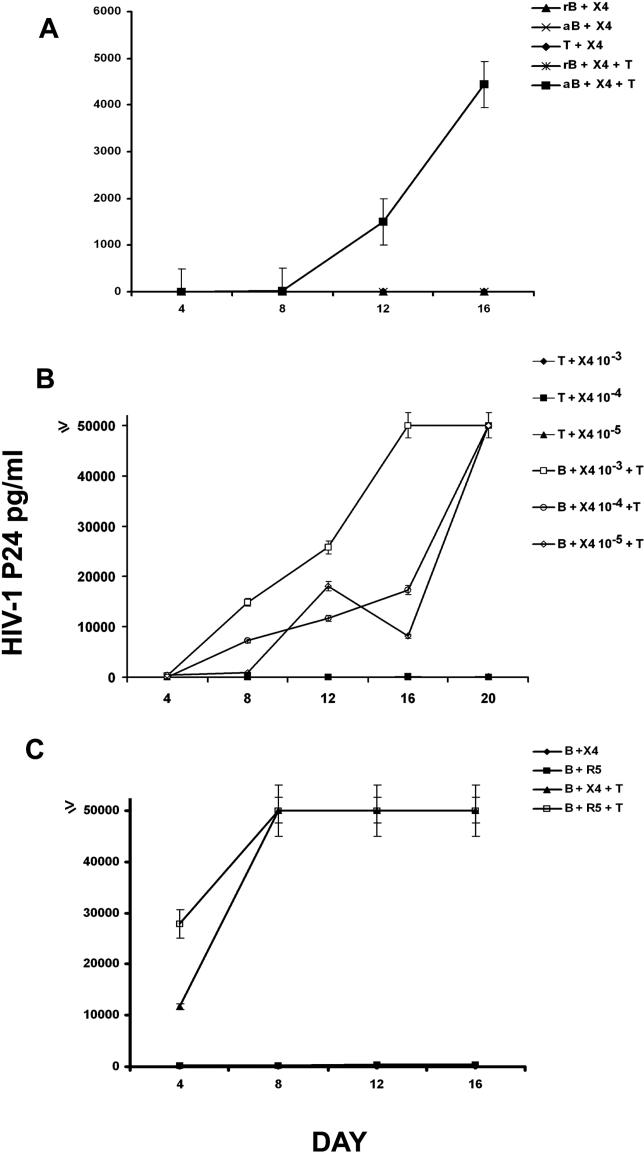
Activated B Cells Transmit HIV-1 X4 and R5 to T Cells(A) Levels of HIV-1 p24 in B cells stimulated with IL-4 and CD40L (activated B cells [aB]) or mock stimulated (resting B cells [rB]) for 24 h and loaded with 10−4 MOI of HIV-1 X4 (IIIb) for 2 h at 37 °C, then extensively washed in cold medium and incubated with purified, autologous CD4+ T cells (T). B cells and T cells directly loaded with HIV-1 served as controls.(B) Dose response of HIV-1 trans infection shown by levels of p24 in cultures of autologous T cells (T) mixed with activated B cells (B) that were loaded with 10−5, 10−4, or 10−3 MOI of HIV-1 X4 (IIIb). The results shown are representative of three independent experiments with B and T cells from different donors.(C) Activated B cells (B) transmitted both HIV-1 X4 (IIIb) and R5 (Ba-L) strains to autologous T cells (T) as shown by increases in levels of p24. T cells and B cells were separately cultured with either strain of virus as controls. Data are represented as the means of triplicates ± SE, and are from single experiments representative of five or more independent experiments.